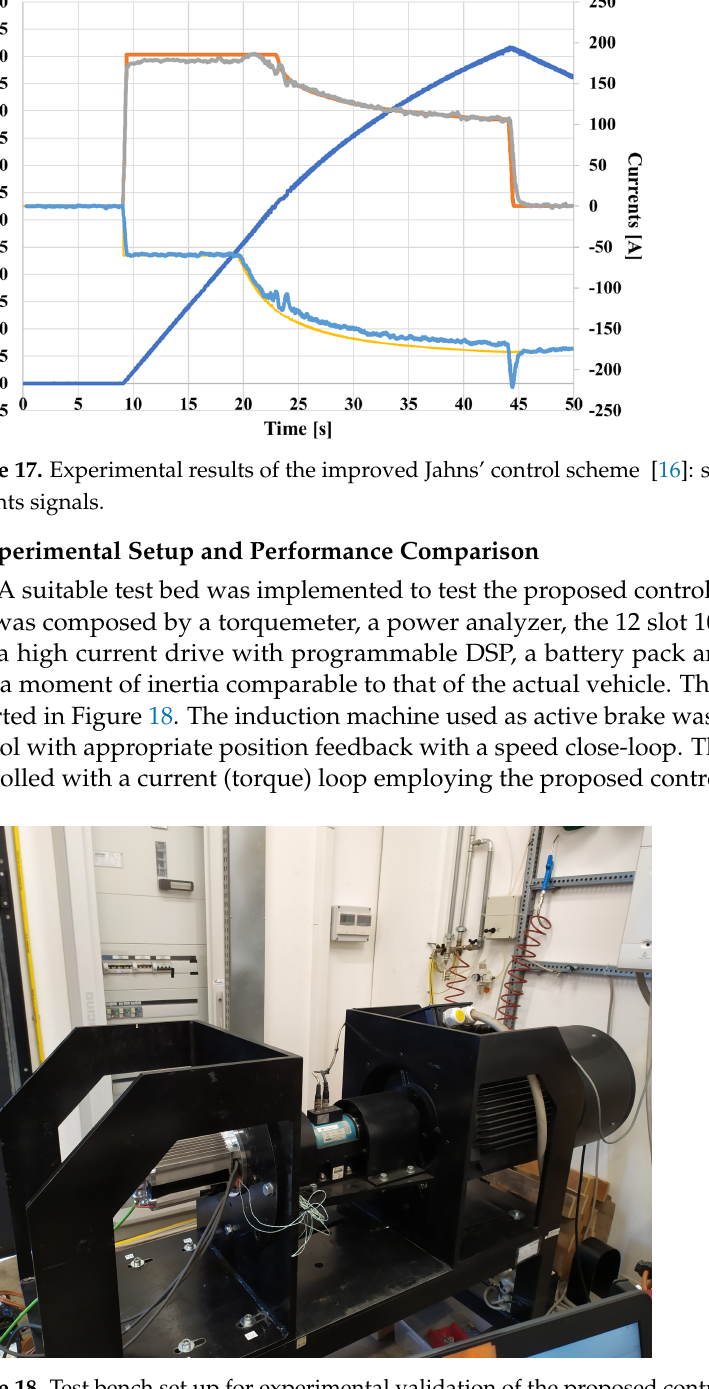
Figure 18. Test bench set up for experimental validation of the proposed control